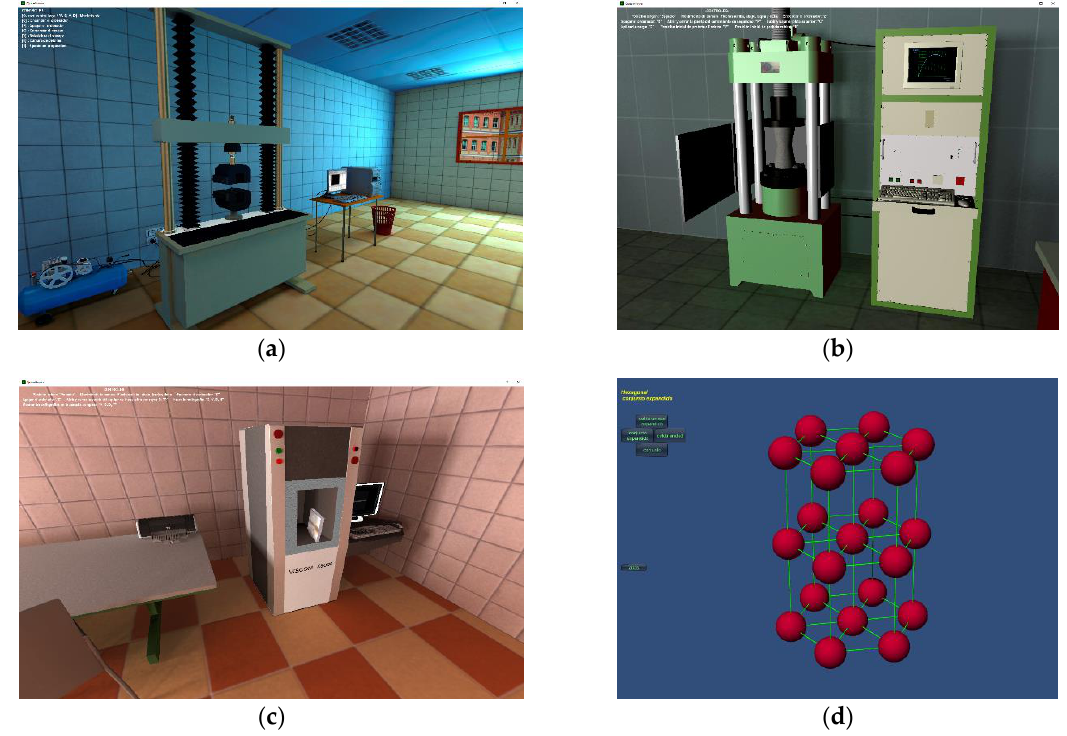
Figure 1. Representative virtual reality learning environments (VRLEs) designed with virtual reality (VR) software several years ago: ( a ) tensile testing; ( b ) compression testing; ( c ) X-ray evaluation; and ( d ) crystal lattices simulation.